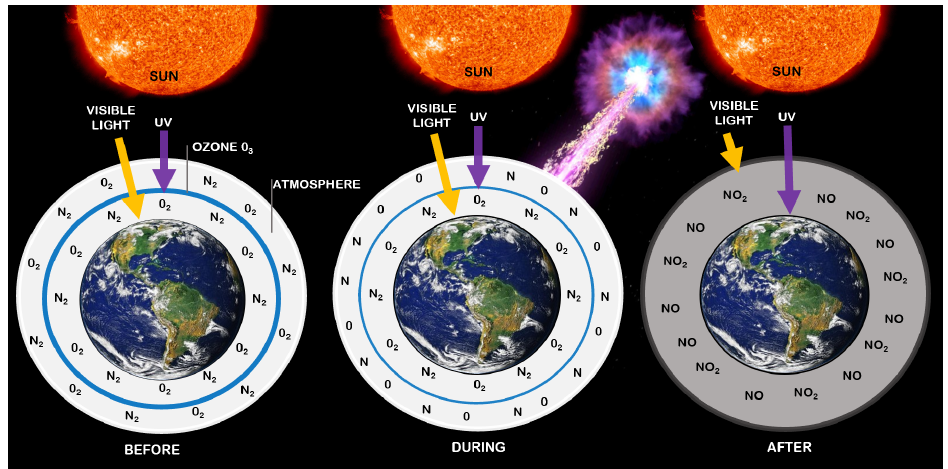
Figure 2. Effect of a gamma ray burst on an Earth-like planet. Before the GRB, the ozone (O 3 )-rich external atmosphere layer (blue circle) shields the planet from UV radiation emitted by its host star. The incidence of a relatively large (with fluence F ą F c (see text)) amount of X-ray and γ ray radiation destroys the O 2 and N 2 molecules, which recombine, producing nitrogen compounds (NO and NO 2 mainly). The latter are catalysts for the depletion of O 3 . As a consequence (after), the host star light can penetrate the atmosphere, reaching the planet surface and thus inducing DNA modification. Side effects are induced by the increased opacity of the atmoshpere to visible light (due to the increase in NO 2 ), which would induce a global cooling effect and the precipitation of NO as acid rains which would damage plants, thus breaking fundamental biological